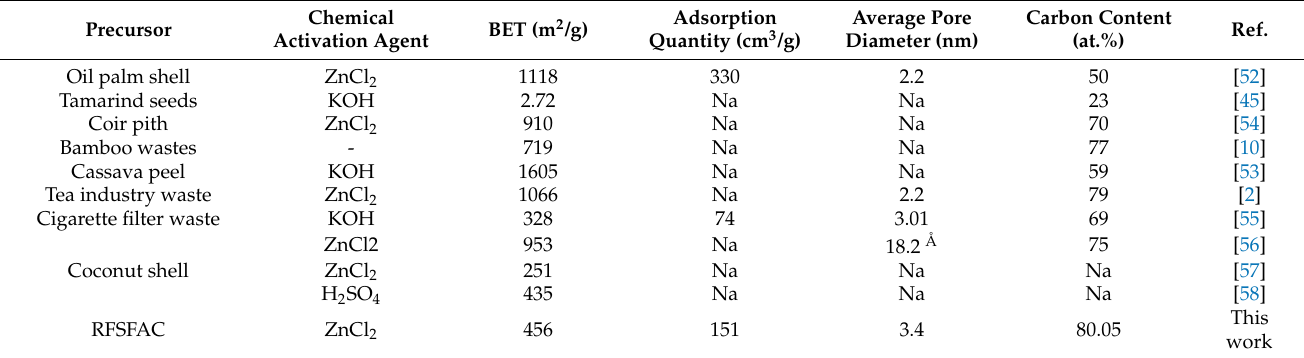
Table 4. Textural properties of activated carbon prepared from various biomass feedstocks.